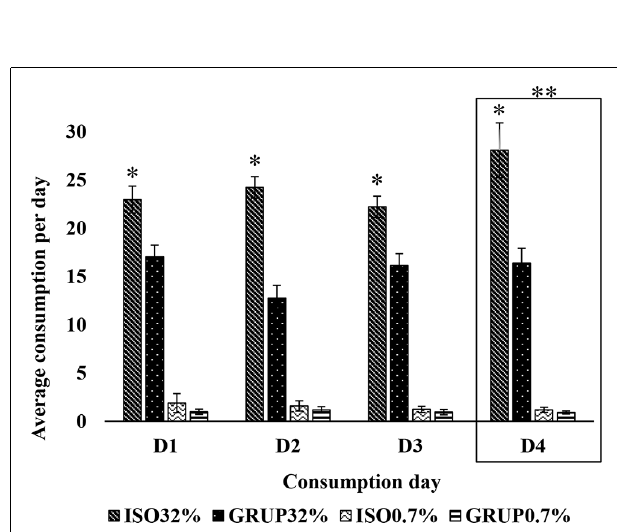
FIGURE 2 | Consumption of 32% sucrose solution vs. 0.7% sucrose solution by groups on D1, D2, D3, and D4. Average consumption (PROM ± EE) of 32% SS vs. 0.7% SS on D1, D2, D3 and D4, in the groups ISO32% (isolated 32%); GRUP32% (grouped 32%); ISO0.7% (isolated 0.7%); GRUP0.7% (grouped 0.7%). ∗ Higher consumption of SS in ISO32% than ISO0 7%. ∗∗ Higher consumption of 32% SS in isolated and grouped on D4 than D1, D2 and D3 (Holm–Sidak Test t, p < 0.05).